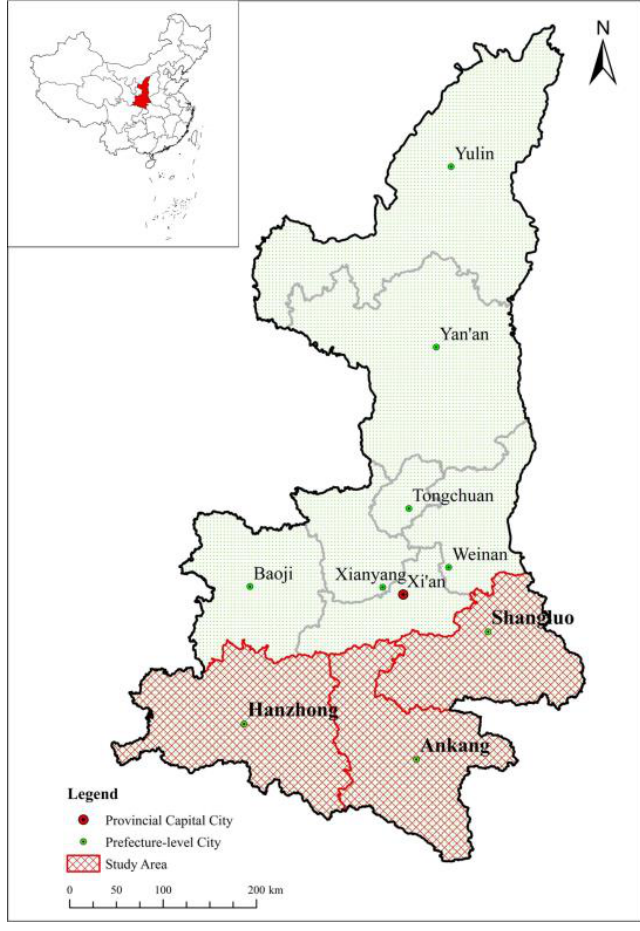
Figure 1. Location of administrative divisions of three cities in southern Shaanxi.